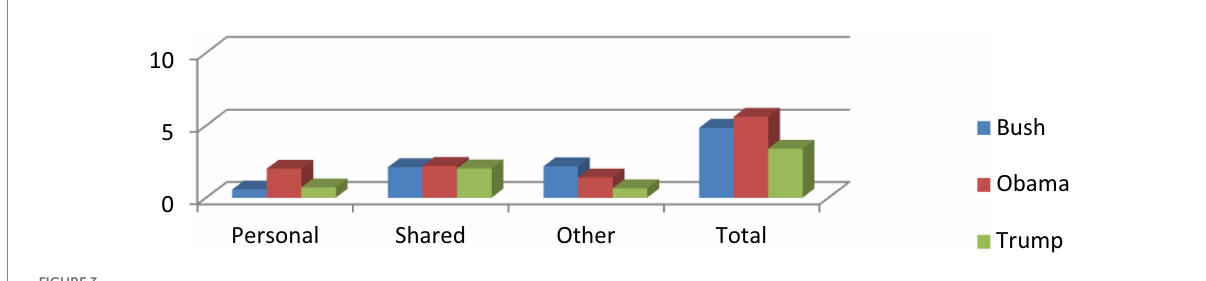
FIGURE 3 A comparison of sources of evidentials in three cases.